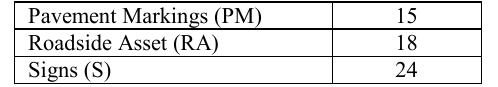
Table 1 . Selected Roadside Asset